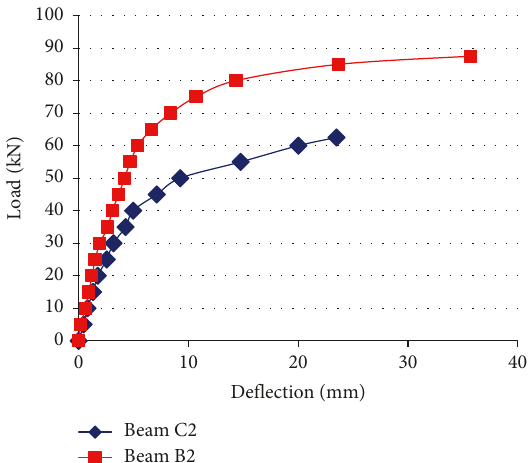
Figure 11: Effect of clear span length of the beam on load deflection response with carbon fiber strengthening.